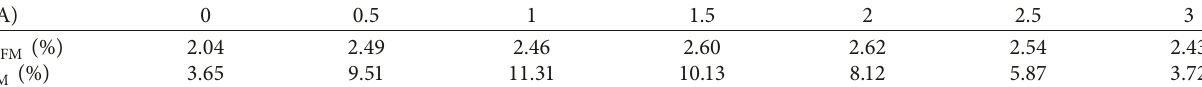
0.02m, f 2 Hz. (cid:31) (cid:31)